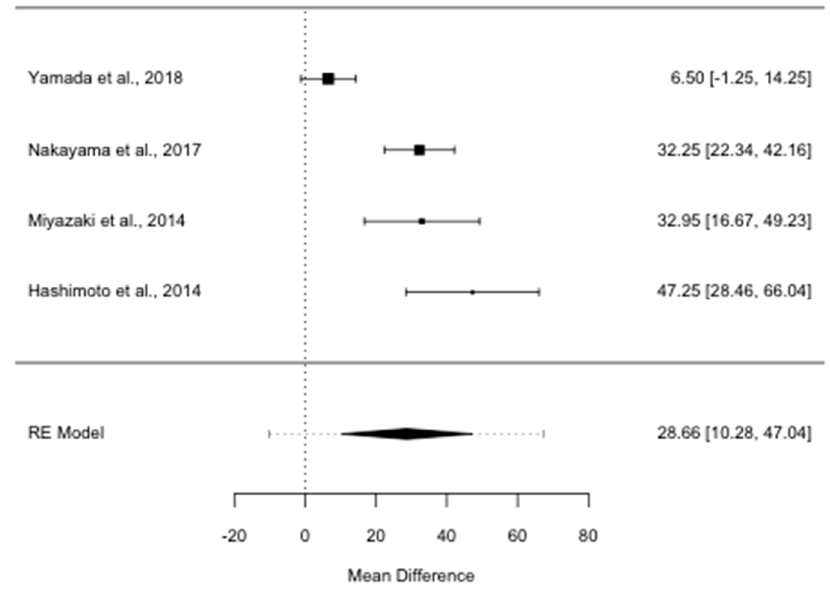
Figure 2. Forest plot for overall survival mean difference in months. RE: random-effects.